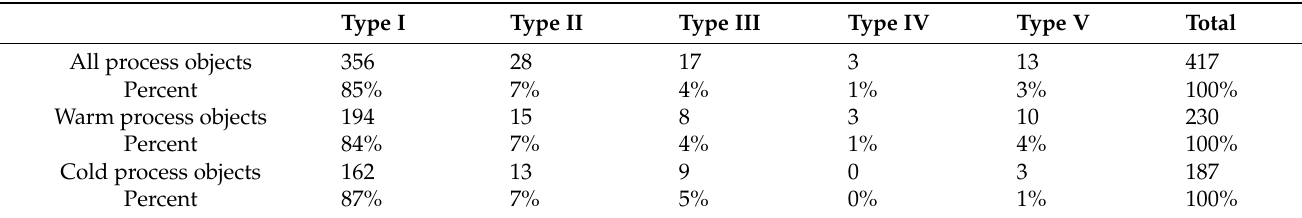
Table 2. Types of evolutionary structure of SSTA dynamics in global